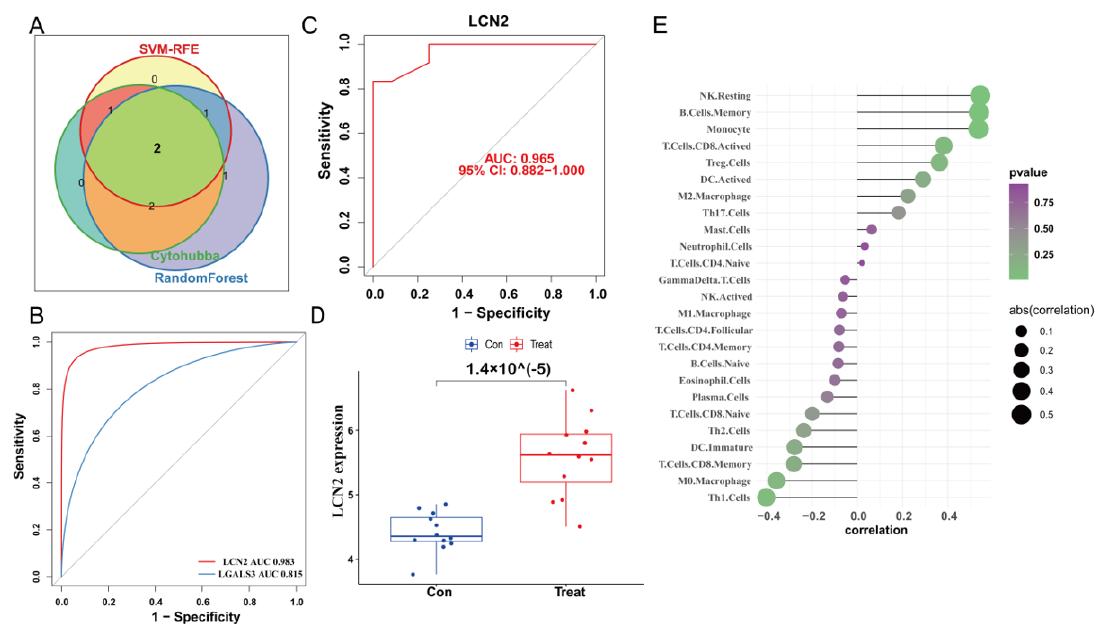
Figure 4. Validation of the diagnostic value of the hub gene. ( A ) Venn diagram indicates the overlapping genes in SVM-RFE algorithm, random forest algorithm and CytoHubba. ( B ) The comparison of two potential biomarkers via GSE23333. ( C ) ROC curves of LCN2 in dataset GSE184997. ( D ) The expression of LCN2 in the dataset GSE184997. ( E ) Lollipop plot showing the correlation of immune cell infiltration and LCN2.